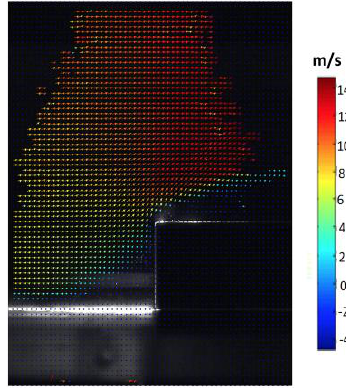
Fig. 5. The image of the front ledge of the body with the airflow velocity field measured by the PIV method (size - 384 × 944 pixels, resolution - 0.166 pixels / mm) exposure time of one frame was 20 μs.